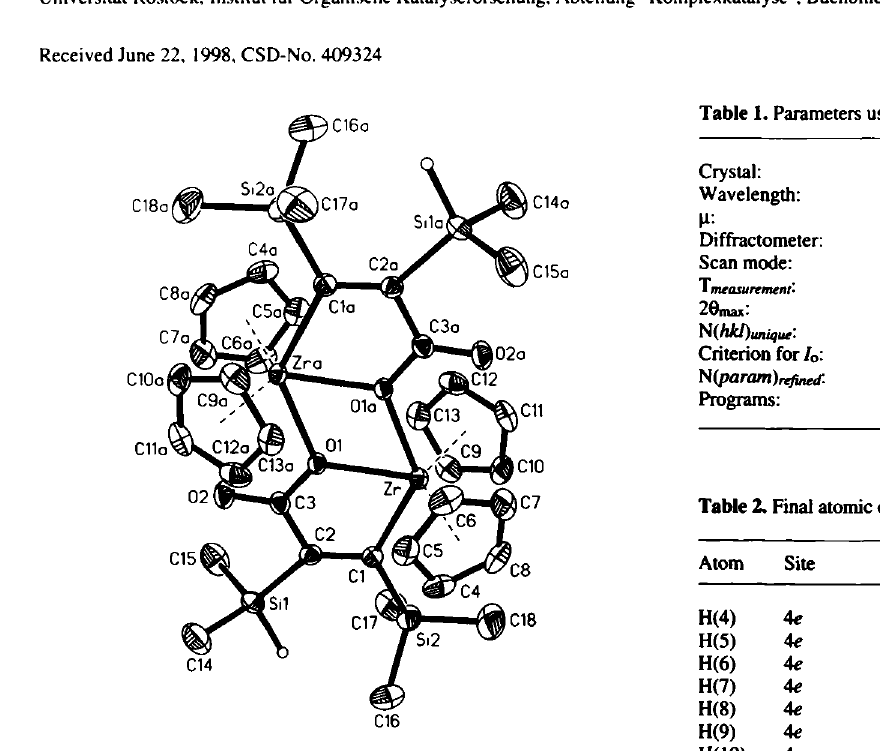
Table 1. Parameters used for the X-ray data collection